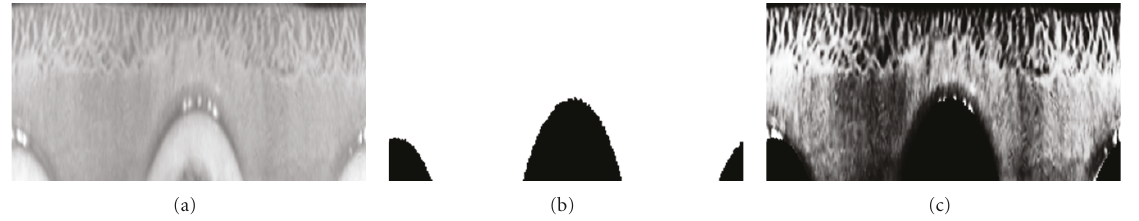
Figure 8: Normalization process. (a) Unwrapped image, (b) binary unwrapped mask, and (c) equalized iris texture with masked occlusions.